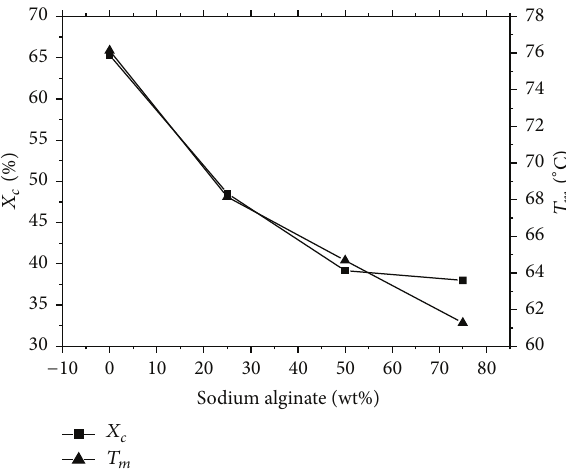
Figure 9: Crystallinity and melting point of electrospun NaAlg/PEO nanofibers with different alginate contents.